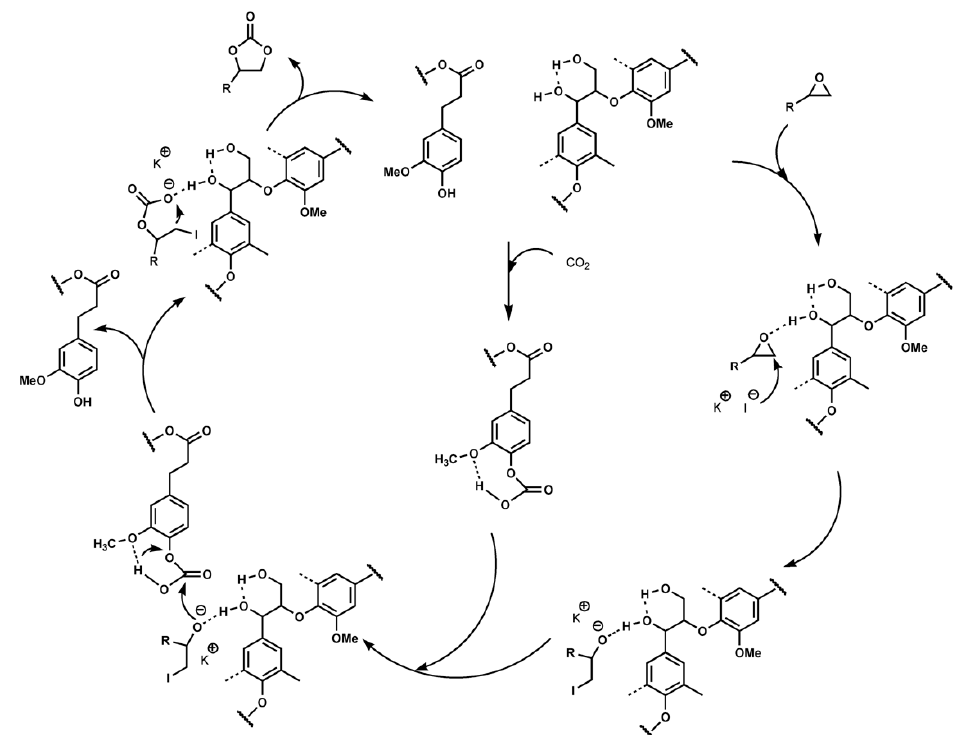
Scheme 7. Mechanism of cyclic carbonate synthesis catalyzed by a lignin-based catalyst. Reproduced from [31] with permission of the American Chemical Society 2019. Molecules 2020 , 25 , x